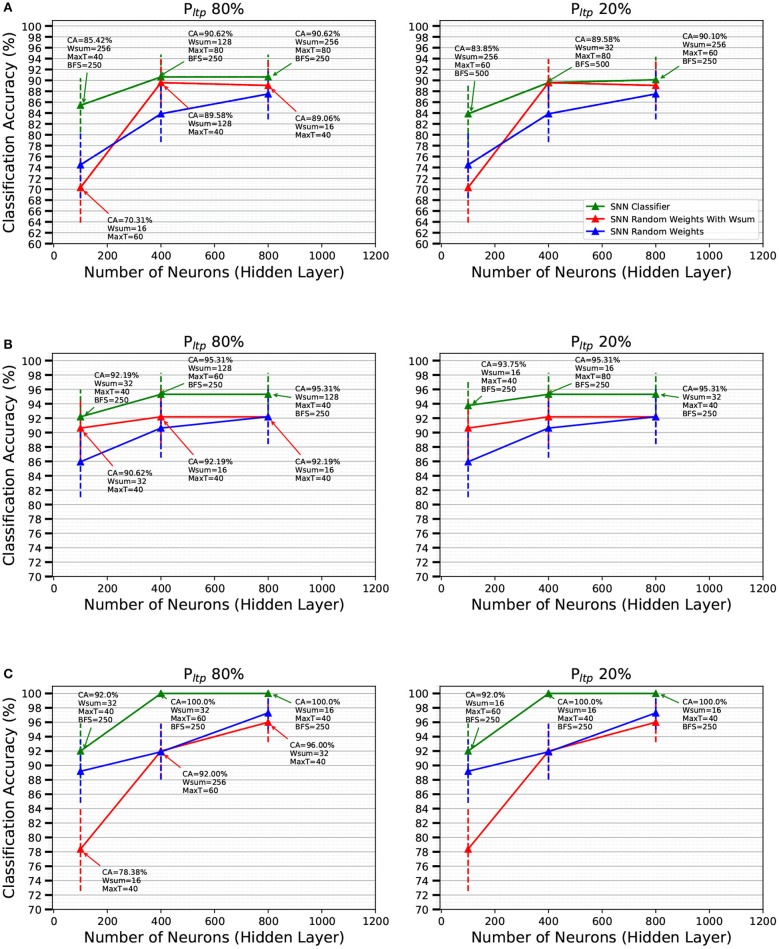
Classification Accuracy (CA) of the SNNs on the Slow-Poker-DVS data set as a function of the number of neurons in the FE layer for a PLTP of 80 and 20%, shown as the green solid line, for (A) 10 kesl, (B) 30 kesl, and (C) 50 kesl. The text at each data point presents the hyper parameters that yielded the best CA on the validation set. The blue solid lines show the CA for random fixed 1-bit weights with no STDP learning in the FE layer, while the red lines show the CA for random fixed 1-bit weights with fixed Wsum applied to restrict the number of active synapses per neuron. PLTP is not applicable for the blue and red solid lines; they are duplicated in each pair of subplots for viewing convenience. The error bars denote the confidence and are calculated for a confidence level of 0.99 and assuming that the test samples are statistically independent (Nowotny, 2014).